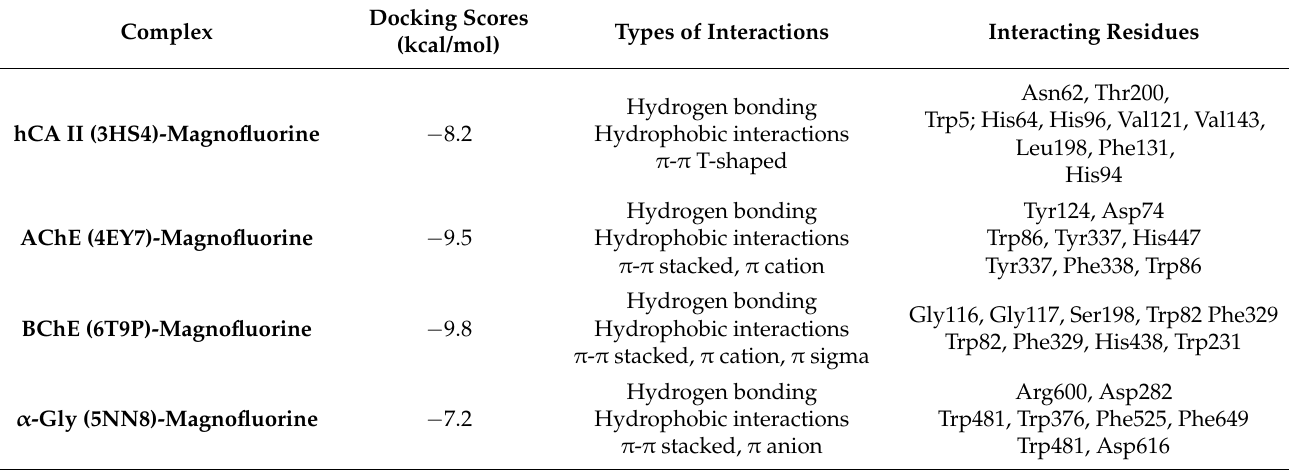
Table 4. Molecular interactions of Magnofluorine with α -glycosidase ( α -Gly, C:5NN8), human carbonic anhydrase isoenzyme II (hCA II, A:3HS4), butyrylcholinesterase (BChE, D: 6T9P), and acetylcholinesterase (AChE, B:4EY7)